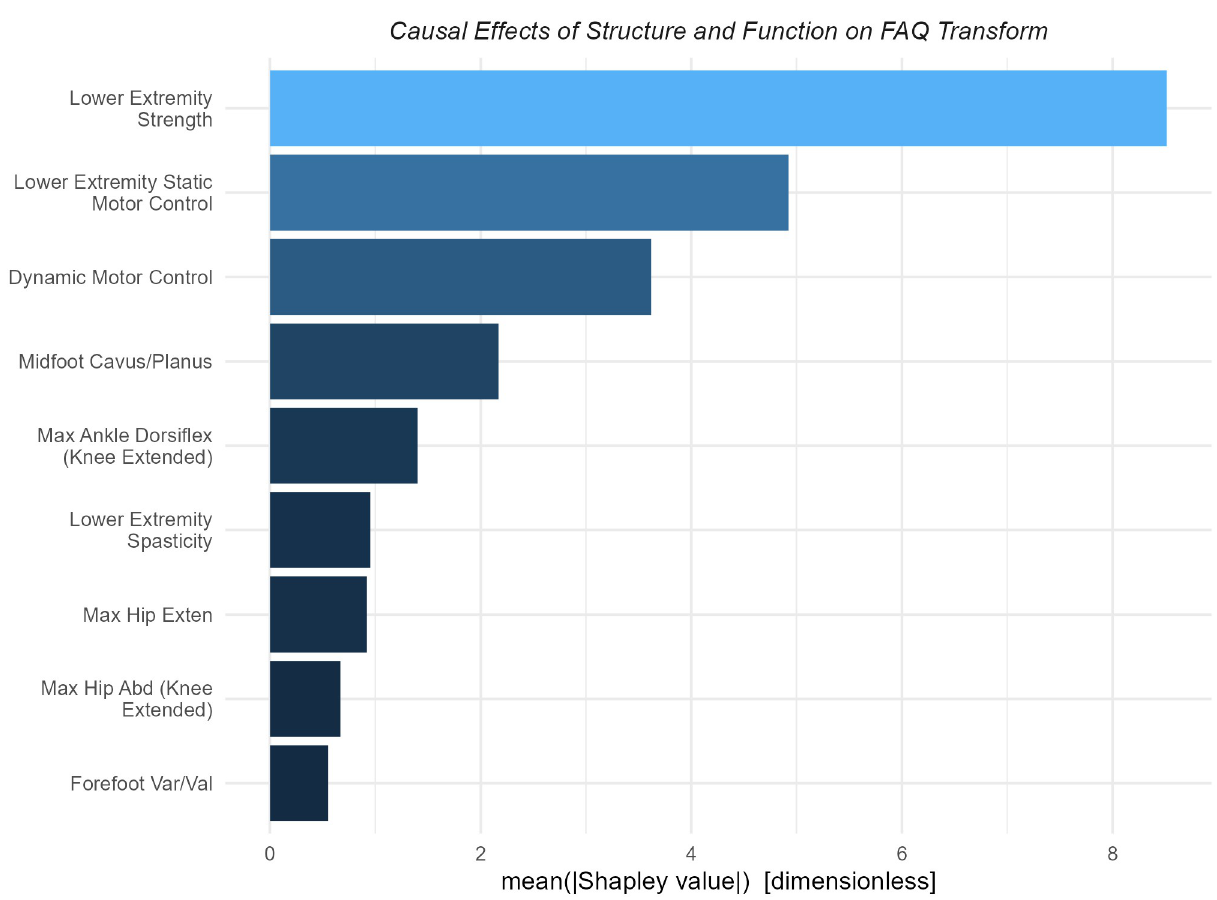
Fig 5. Importance of Structure and Function on FAQt. Strength and motor control (static and dynamic) are the main contributors to mobility as measured by the FAQt. These neurological variables have effects around two- to four-times larger than any other variable.